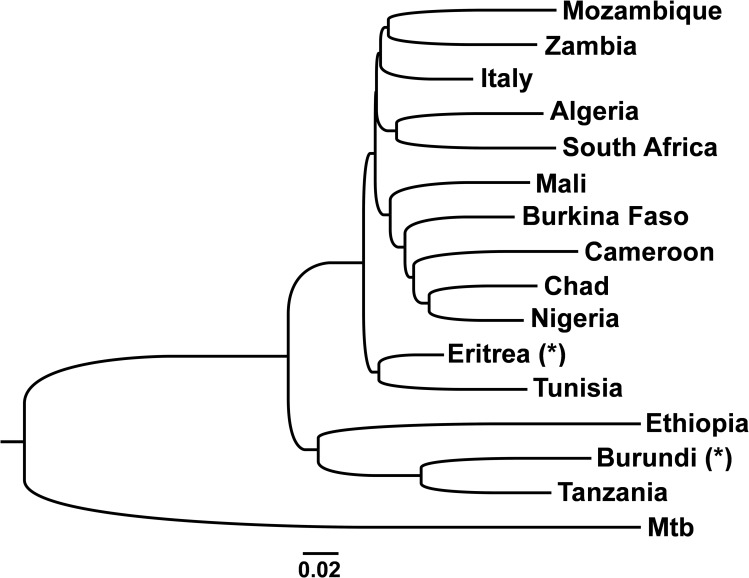
Neighbour-joining population tree based on a matrix of Fst values between populations.A dataset of European M. tuberculosis (Mtb) was used as an outgroup. Sample sets indicated as (*) have a low sample size and their placement in the tree is possibly uncertain.